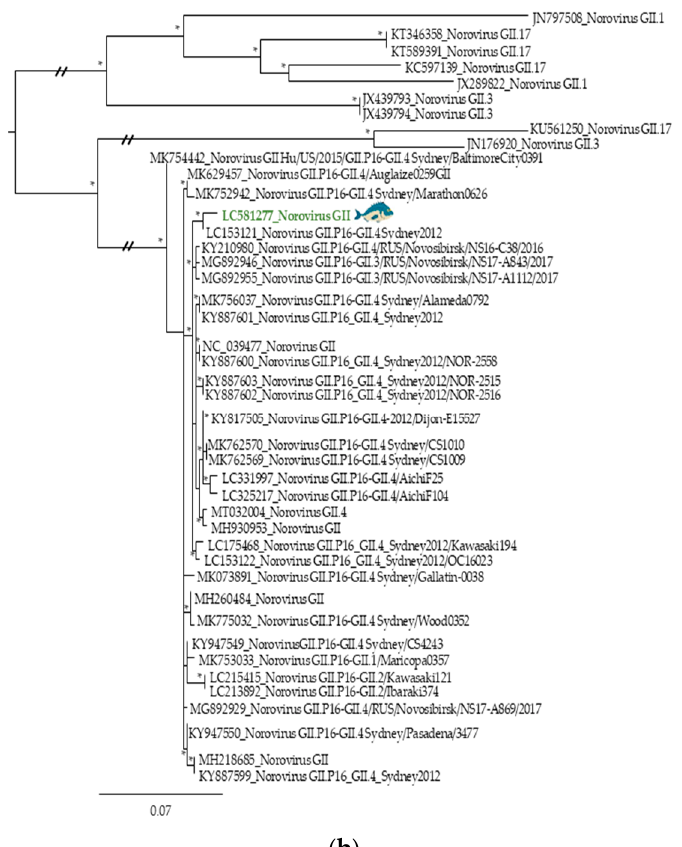
Figure 5. Phylogenetics trees of human pathogenic viruses identified in this study: ( a ) Picornaviridae —partial sequence of Rhinovirus A obtained from gilthead seabream skin from Peniche; ( b ) Caliciviridae —partial sequence of Norovirus GII amplified from gilthead seabream skin from Algarve. The viral sequences analyzed in this study are colored and highlighted by a blue fish. All viral sequences are identified by their accession number and name; all viral sequences used are from human hosts. At specific branch nodes bootstrap values ≥ 0.60 are displayed by *.